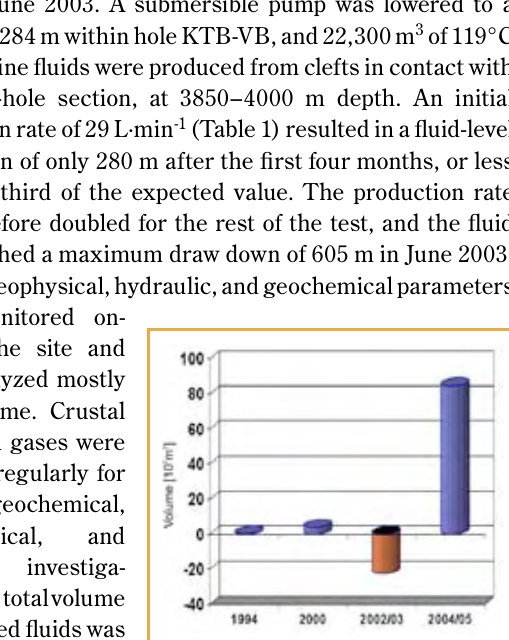
Figure 2. Volume of water mobilized in hydraulic tests at KTB. Tests in 1994 and 2000 were applied to KTB-HB, tests in 2002–03 and 2004–05 to